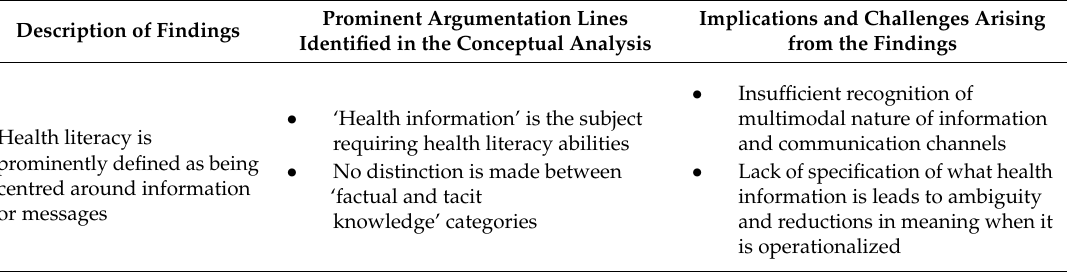
Table 5. Summary of conceptual reflections regarding ‘health information’ within health